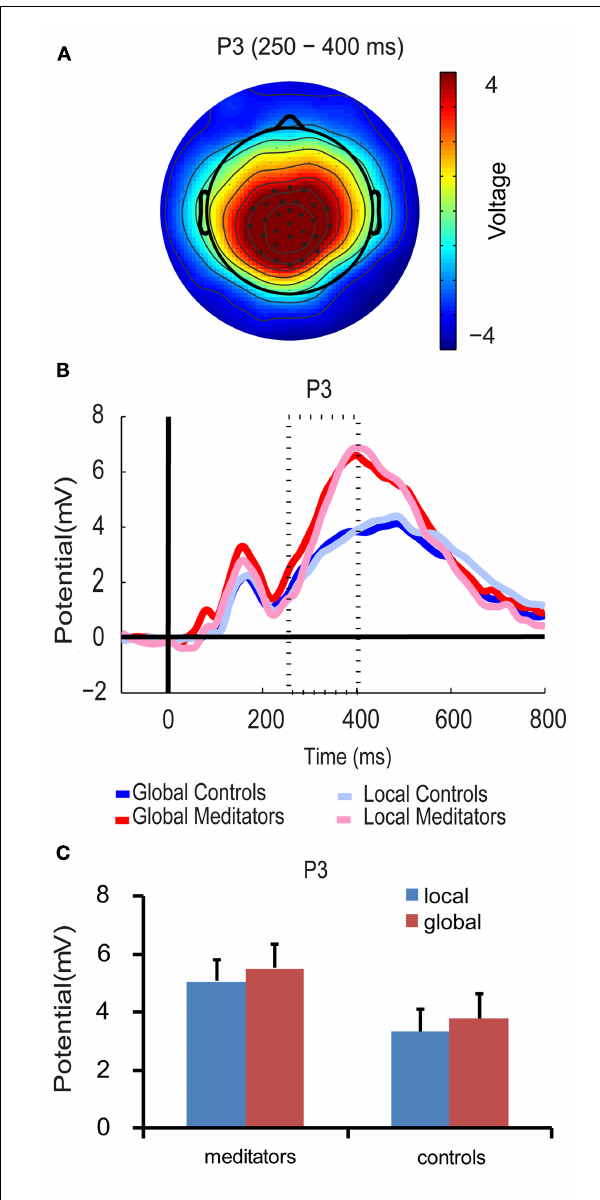
FIGURE 6 | P3 component. (A) Scalp topographies of the P3 component over conditions, groups, and the P3 time period (250–400ms). Black dots represent the electrodes included in the analysis. (B) P3 waveforms. (C) Bar plots show amplitude responses for each group (meditators/controls) and target level (global/local) averaged over the corresponding time period and electrodes. Error bars represent the SEM.